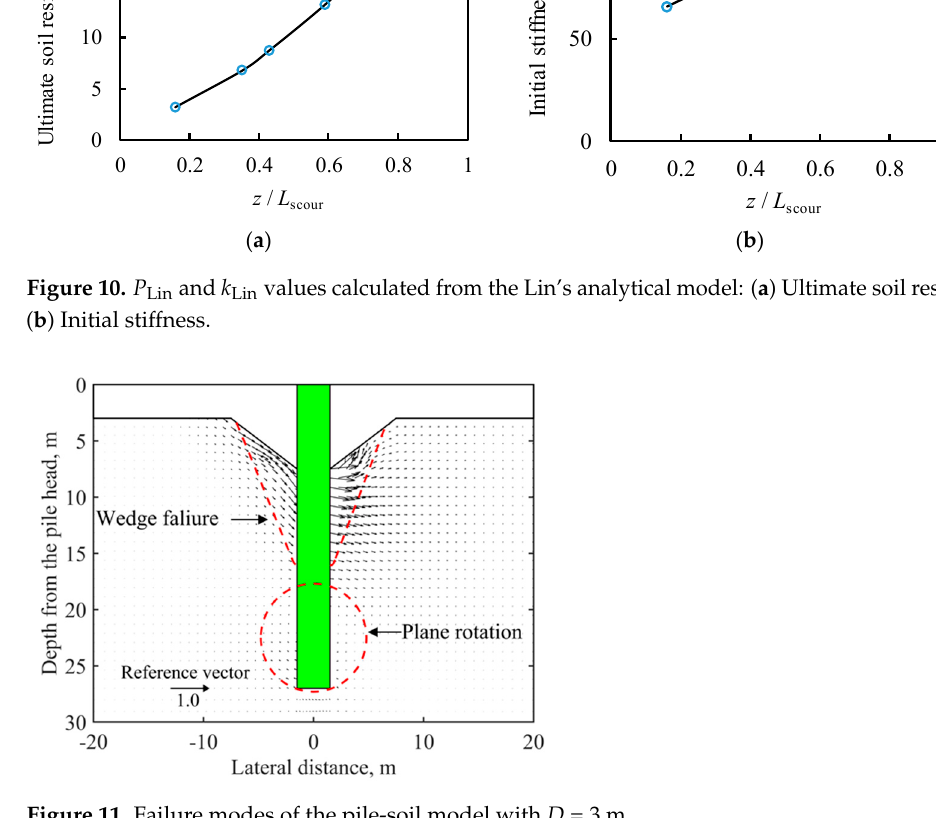
Figure 11. Failure modes of the pile ‒ soil model with D = 3 m.